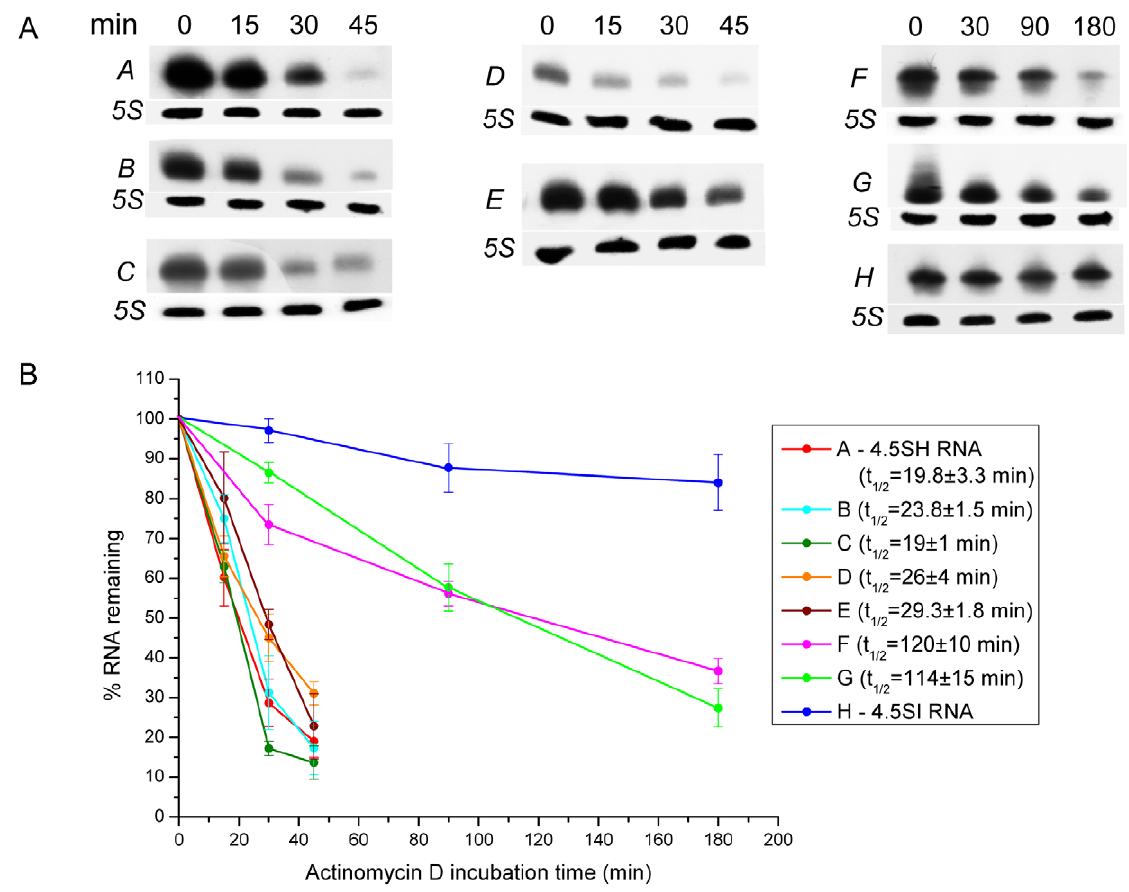
Figure 4. Determination of half-life of 4.5SH RNA and its derivatives in transfected HeLa cells. ( A ) Detection of 4.5SH RNA, its derivatives, 4.5SI RNA and 5S rRNA (loading control) by Northern hybridization. ( B ) Decay kinetics of RNAs transcribed from transfected constructs. Each graph is based on data from three transfection experiments (error bars, s.d.). Average half-lives with standard deviations for RNAs transcribed from each construct except H (long-living 4.5SI RNA) are presented.